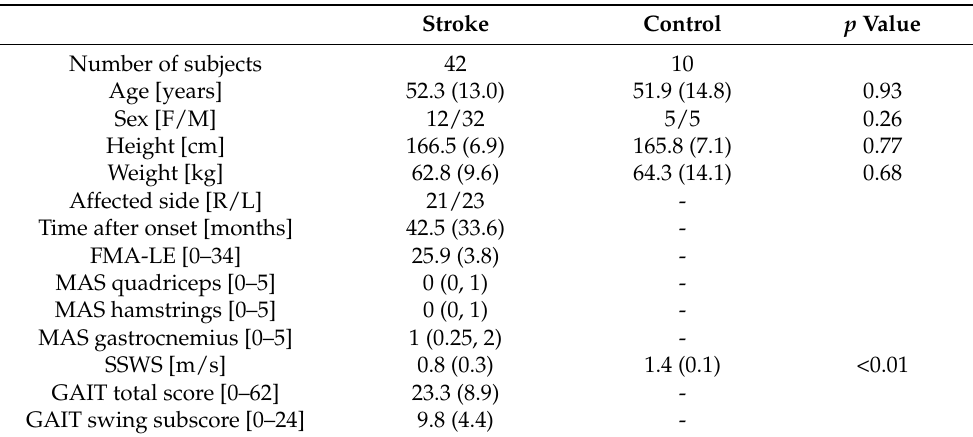
Table 1. Demographic characteristics and clinical measures.